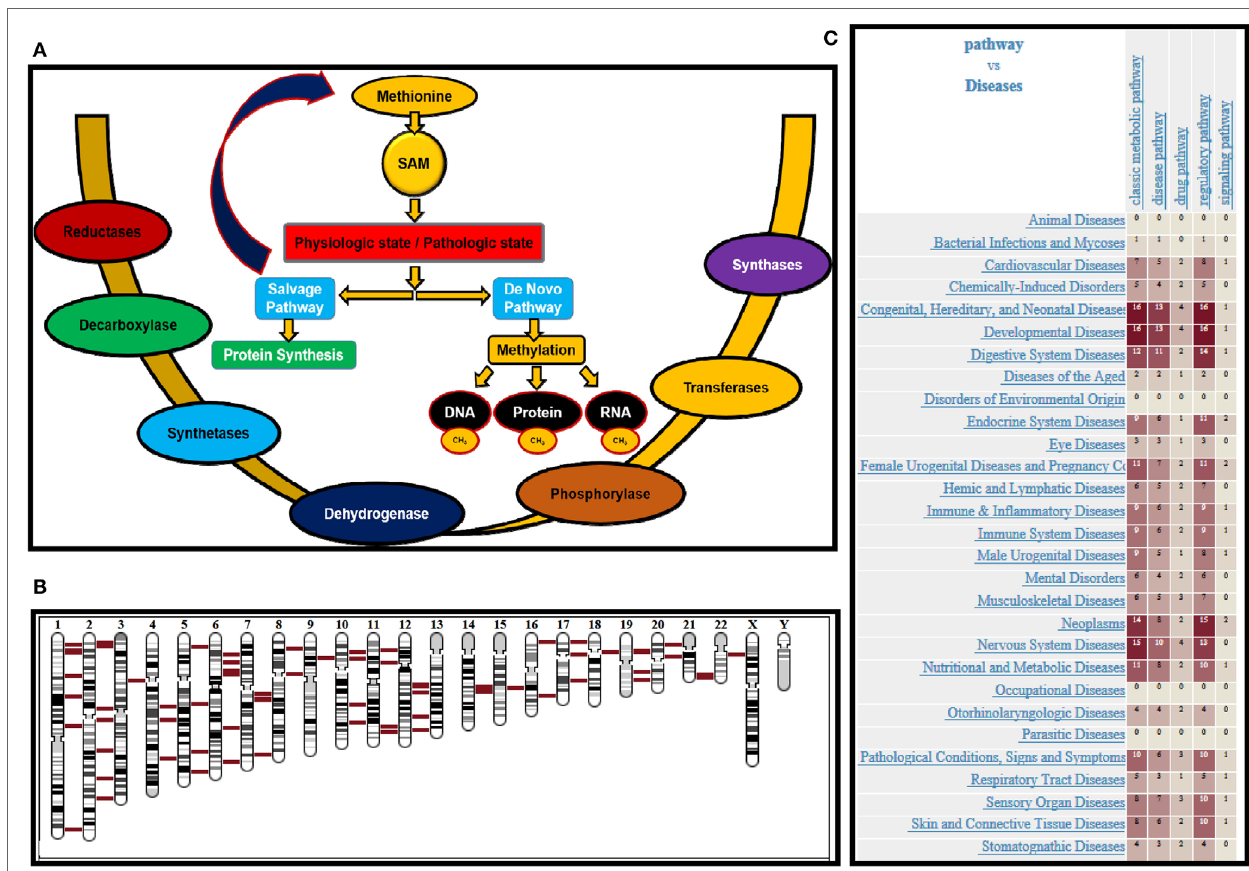
FiGURe 1 | (A) Schematic representation of methionine uptake and utilization by nucleic acids and proteins under pathologic and physiologic conditions. Various enzymes governing the process are provided. (B) Chromosomal location of various enzymes involved in methionine regulation is shown in red. (C) Heat map provides the disease associations with genes that are mapped in methionine